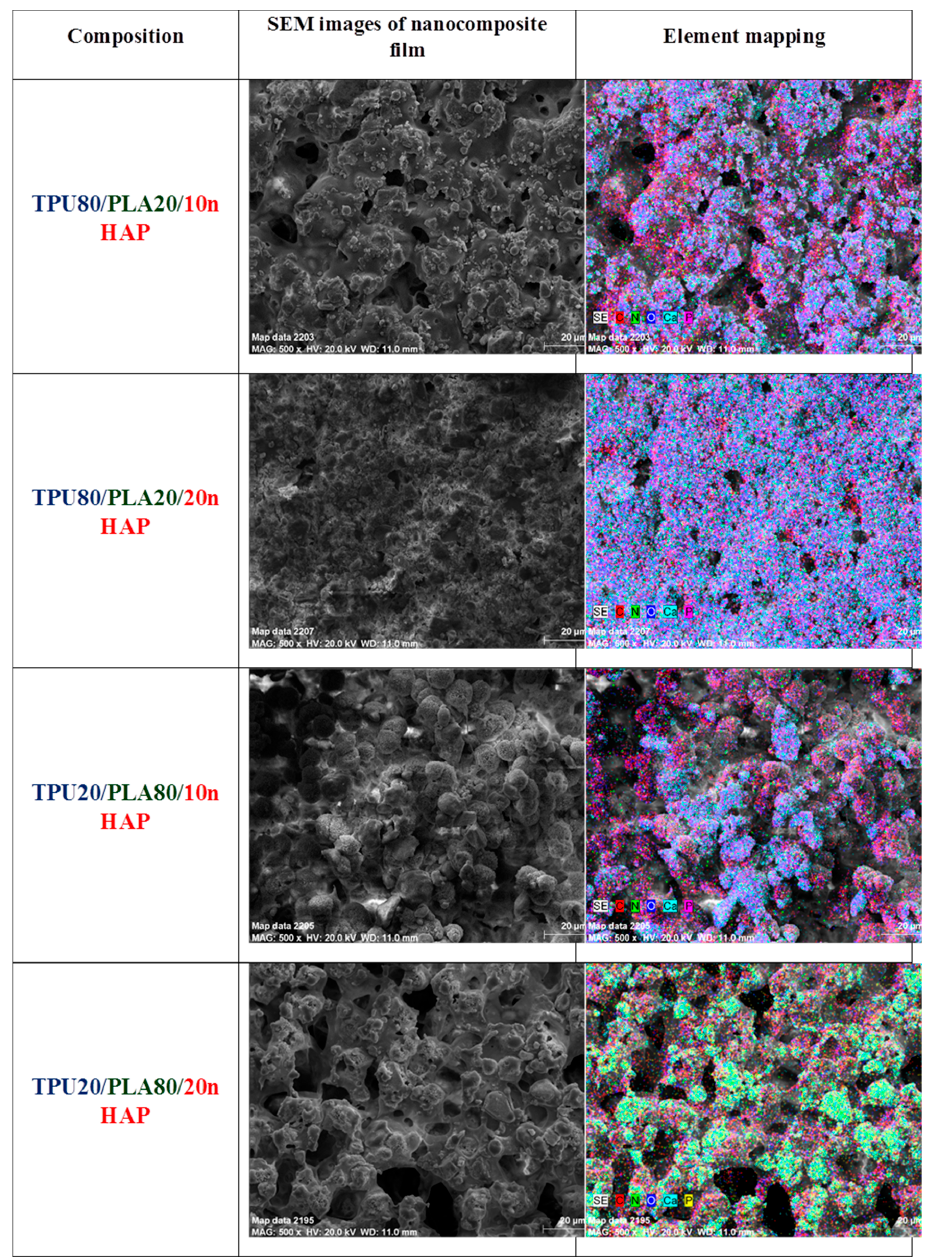
Figure 3. Elemental mapping on the TPU/PLA/nHAP film surface: C (red), N (green), O (blue), Ca (cyan), and P (magenta), magnification 500×.